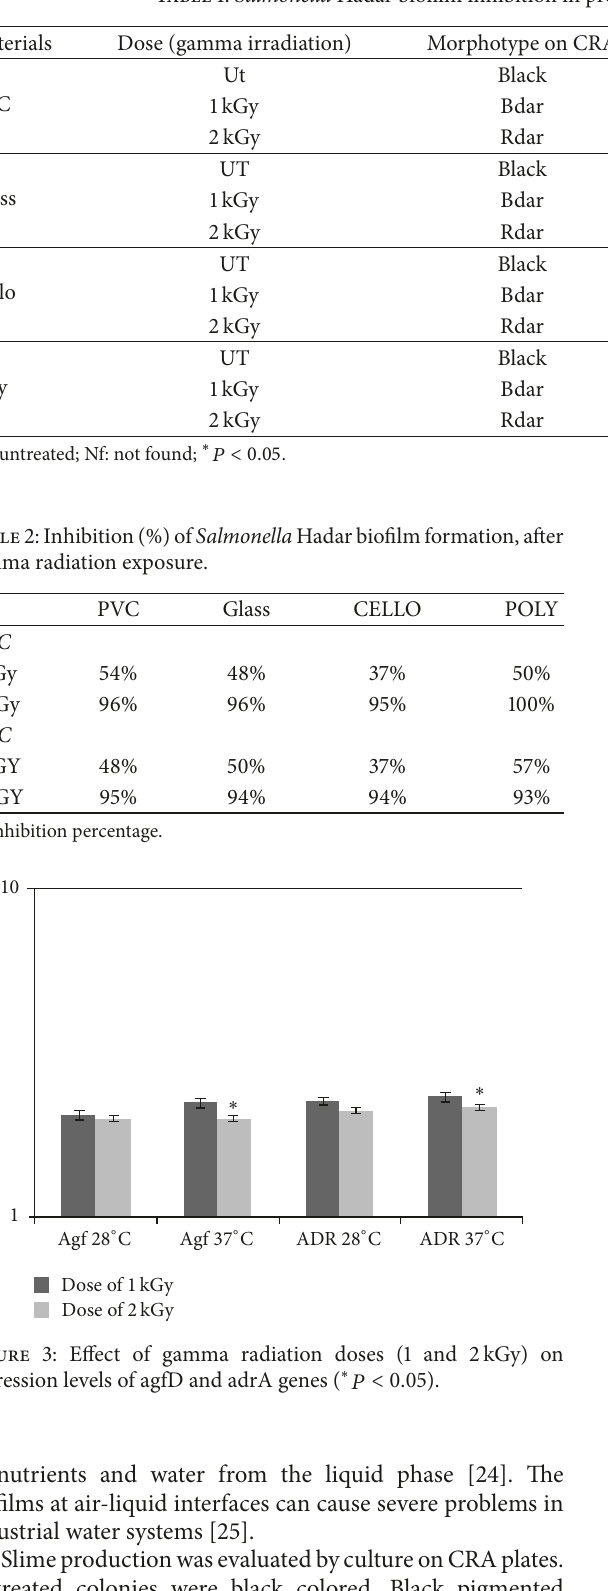
Table 1: Salmonella Hadar biofilm inhibition in presence of incremental gamma radiation doses.